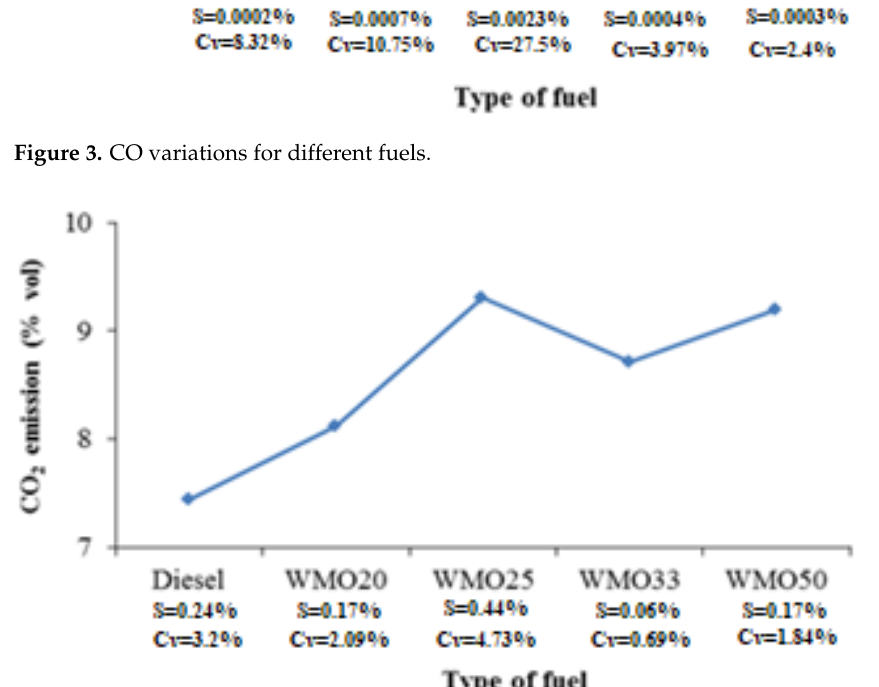
Table 3. Medium measured values of fuel combustion parameters. Parameter